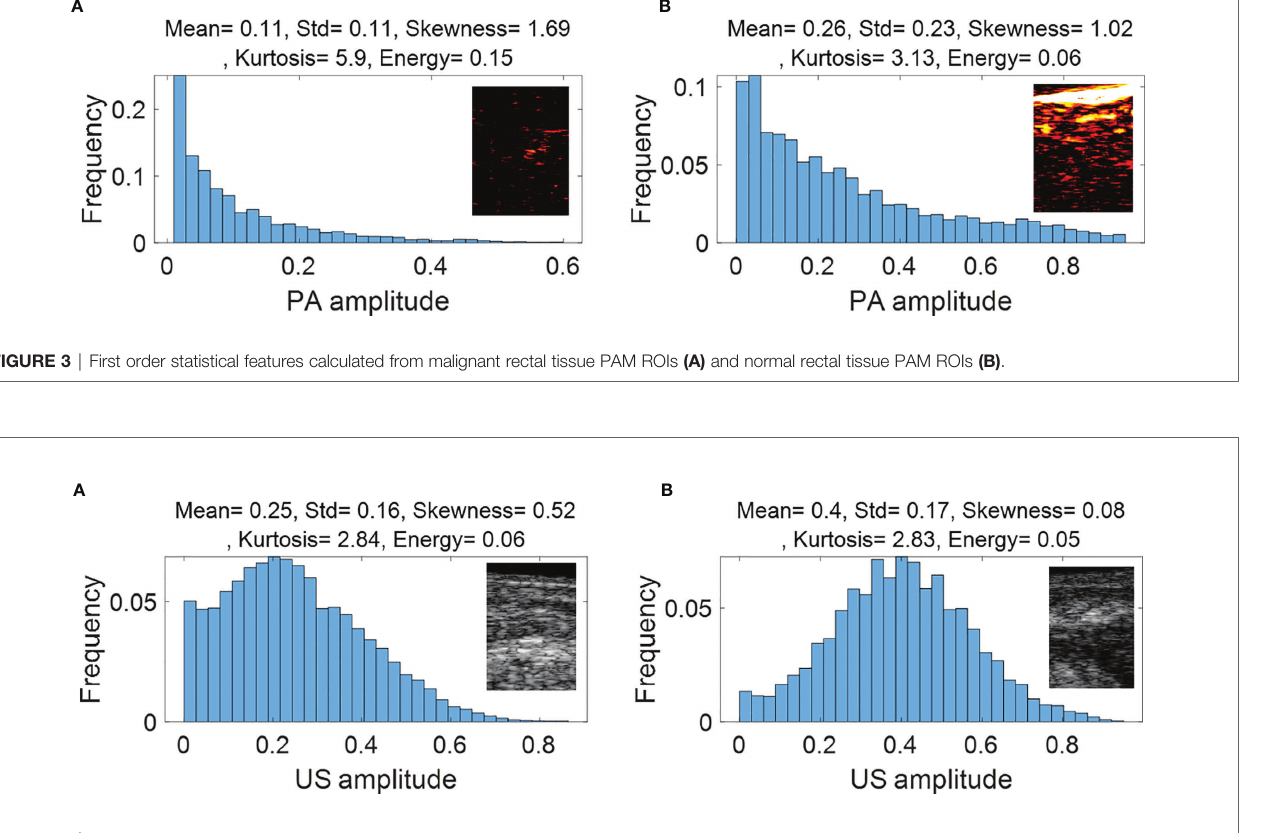
FIGURE 4 | First order statistical features calculated from malignant rectal tissue US ROIs (A) and normal rectal tissue US ROIS (B) .